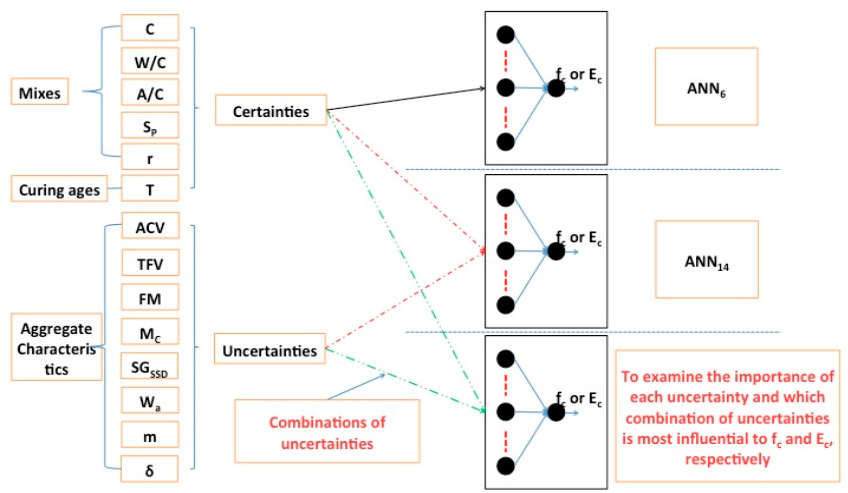
Figure 2. Flow chart of the sensitivity analysis